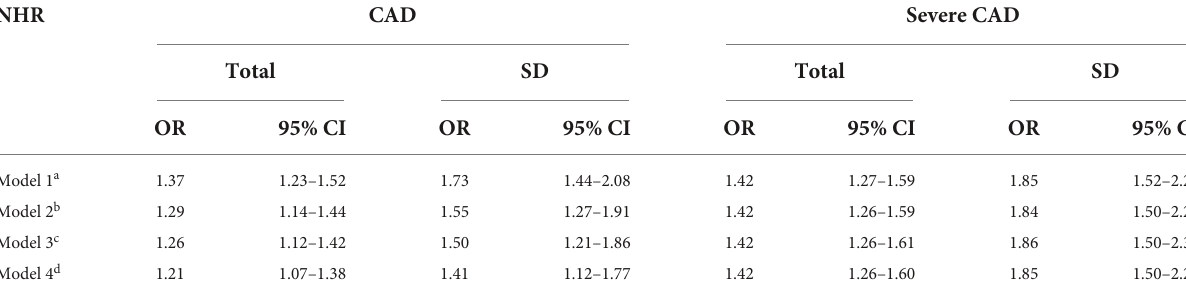
TABLE 4 Association of NHR levels with coronary artery disease (CAD) and severe CAD. NHR CAD Severe CAD